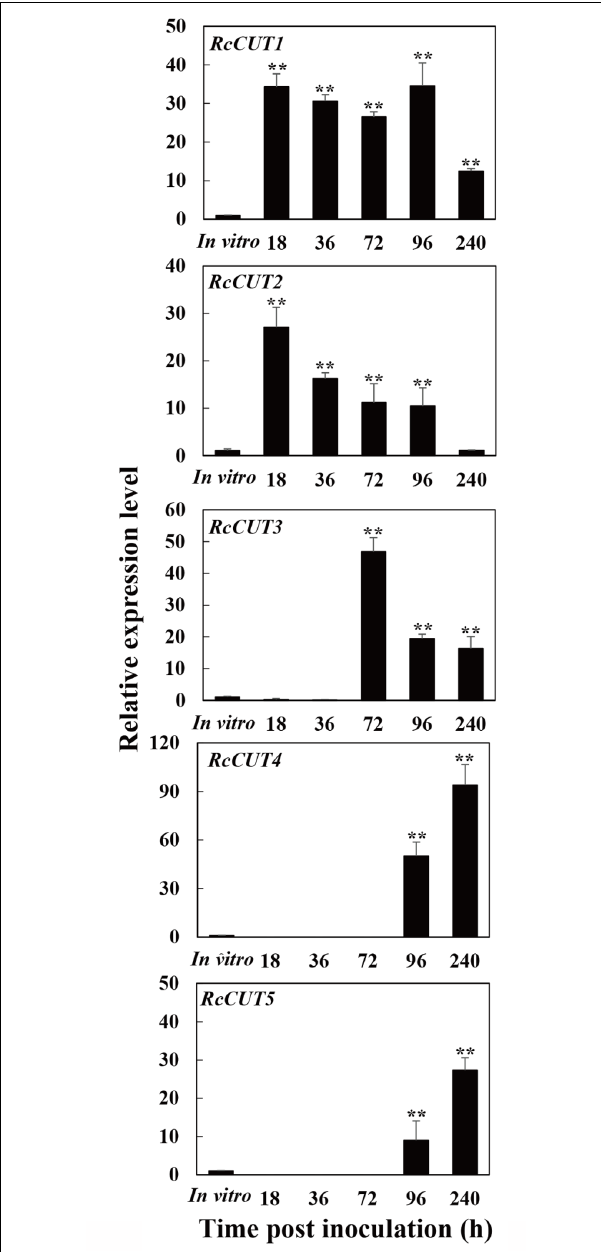
FIGURE 2 | Expression patterns of the RcCUT genes in Rhizoctonia cerealis during the infection to wheat stems. The R. cerealis Actin gene was used as an internal control to normalize the data. The expression of each cutinase gene was investigated during the infection process to wheat stems, including five different infection time points (18, 36, 72, 96, and 240 hpi) and compared to that in vitro culturing. Error bars were calculated based on three replicates. Asterisk ∗∗ indicates significant difference between the pathogen-inoculated sample and in vitro sample ( t -test; P < 0.01).